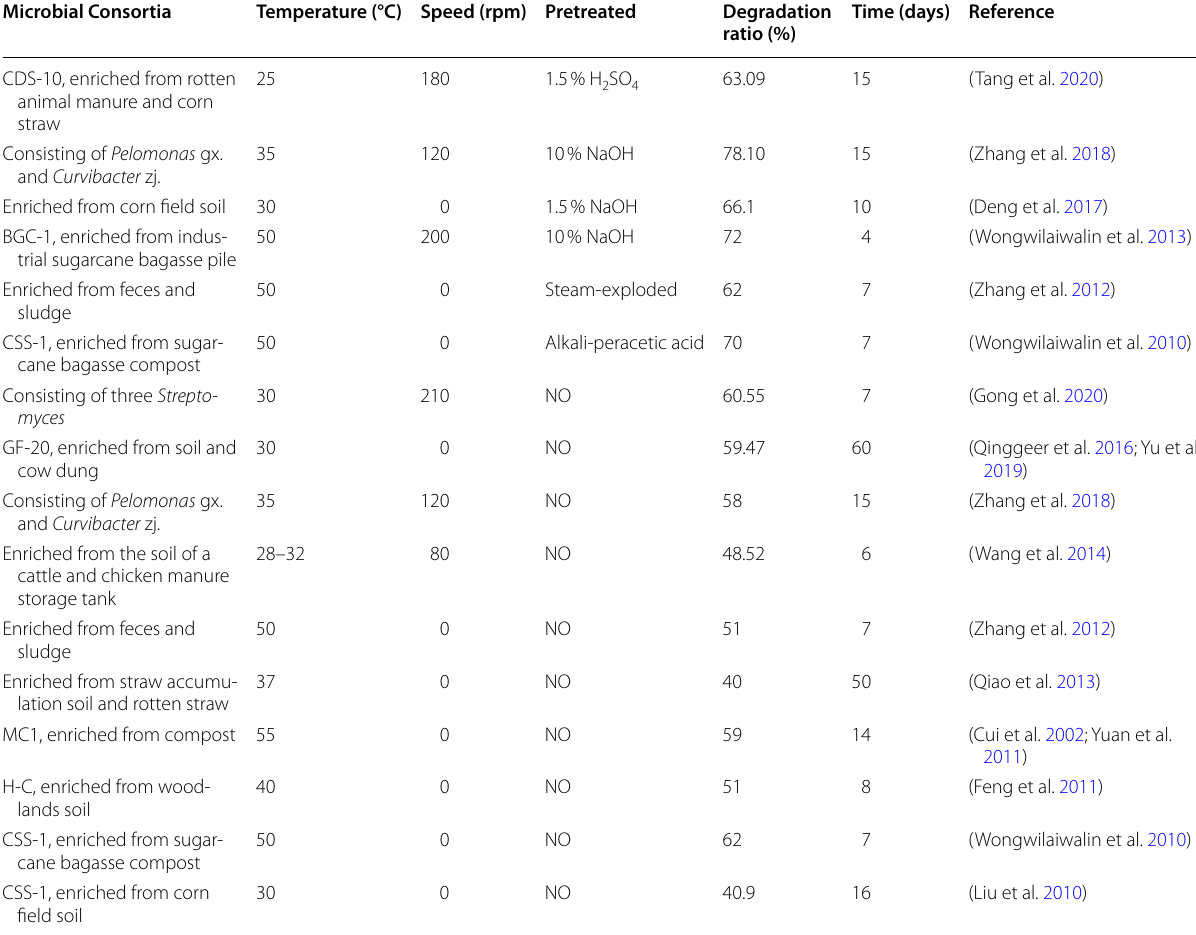
Table 1 Microbial consortia degrading corn stover Microbial Consortia Temperature (°C) Speed (rpm) Pretreated CDS-10, enriched from rotten animal manure and